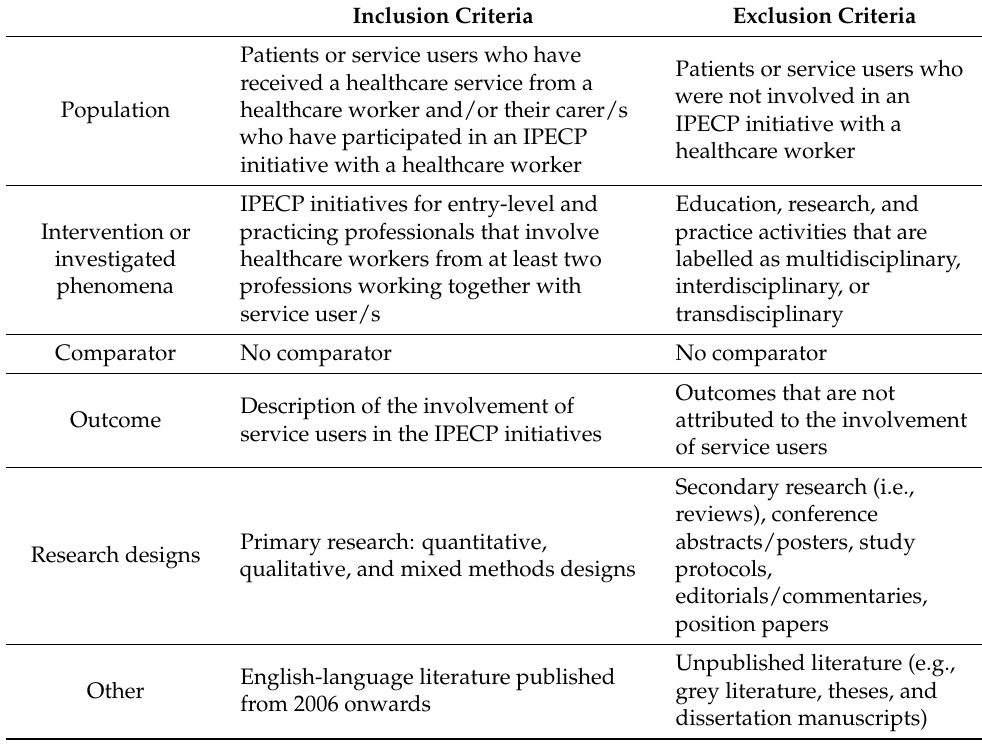
Table 1. Inclusion and exclusion